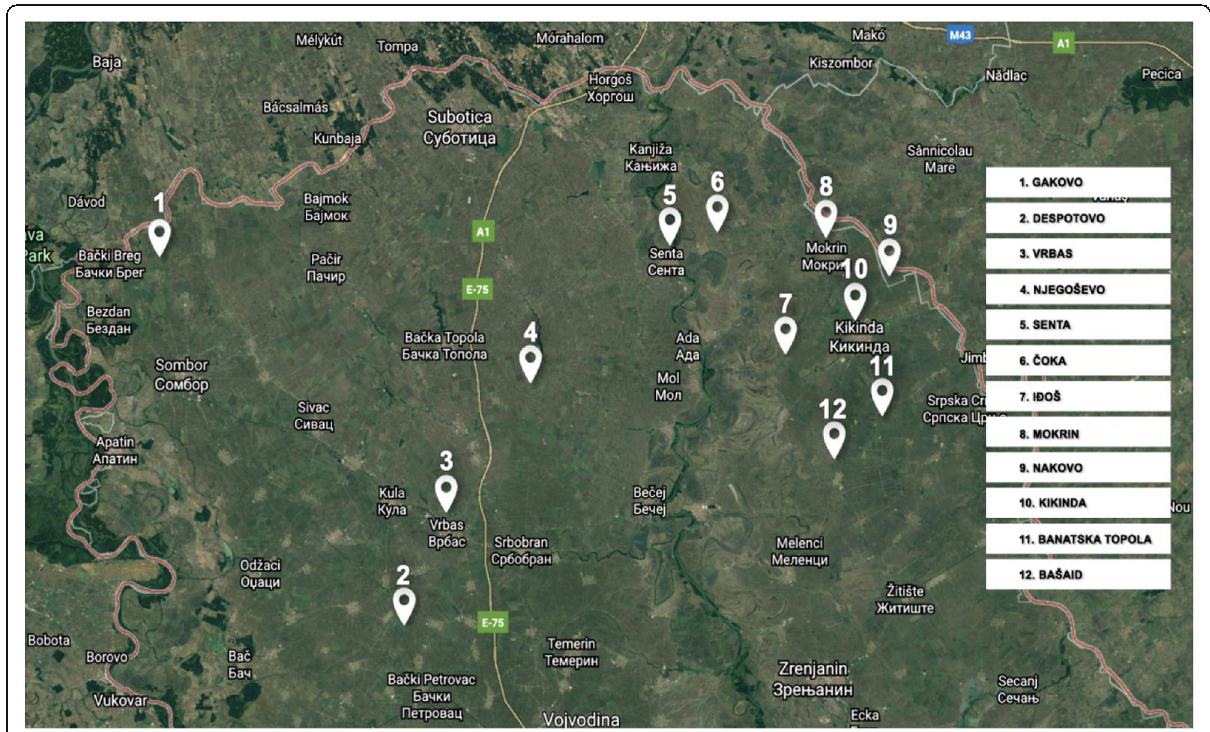
Fig. 2 Locations in Vojvodina where corn crops were sampled in search of parasitized ECB egg masses. Samples were collected in 2017. Map was extracted from Google Maps (earth.google.com/web/) with modifications in Adobe photoshop